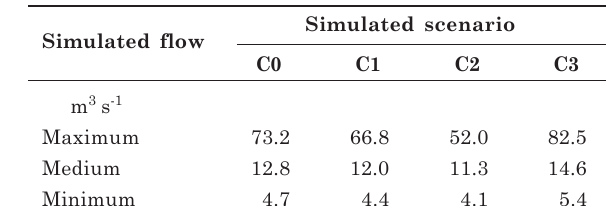
Table 5. Simulated maximum, medium